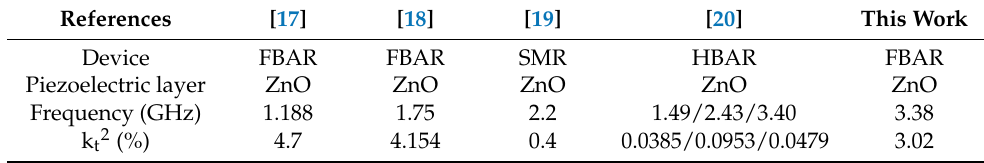
Table 6. The performance parameters of FBAR/HBAR/SMR devices with ZnO thin films.